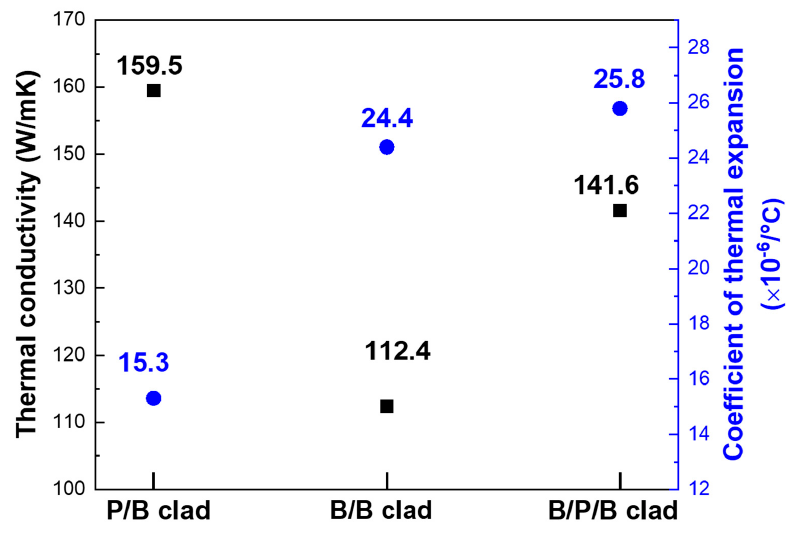
ffi cients of thermal expansion of Al / SUS clads. Materials 2020 , 13 , x FOR PEER REVIEW